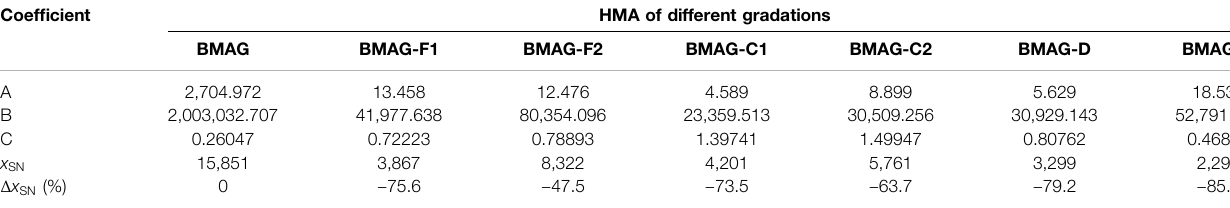
TABLE 5 | Coef fi cient values of regression equations for load cycle times and rut depth of BMAG and variability gradation